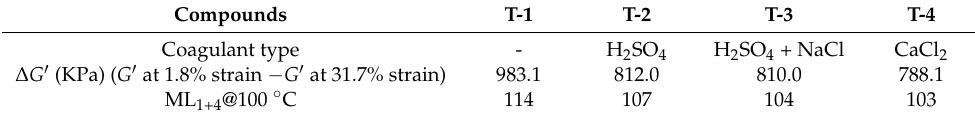
Table 7. Payne effect ( ∆ G (cid:48) ) and Mooney viscosity (ML 1+4 @100 ◦ C) of the T-1 to T-4 compounds.